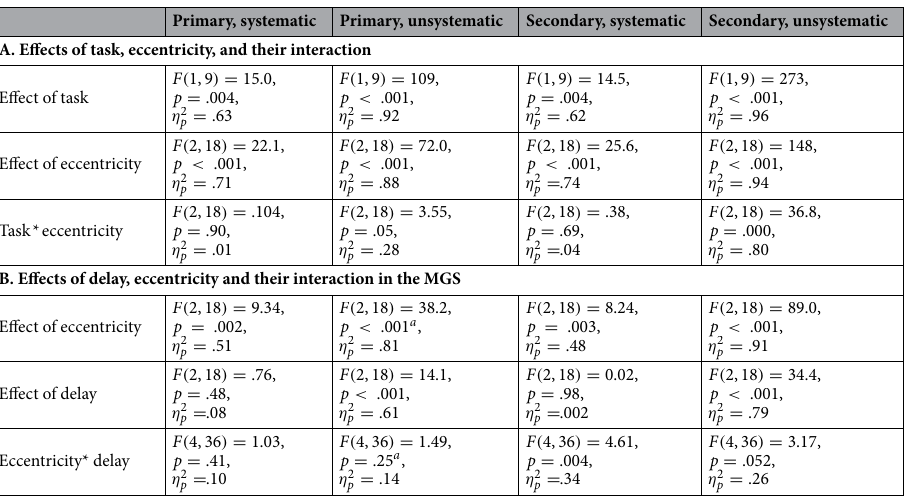
Table 1. Repeated-measures analyses of variance on VSWM errors in Experiment 1. “a” indicates p-value corrected by the Greenhouse–Geisser method due to violation of